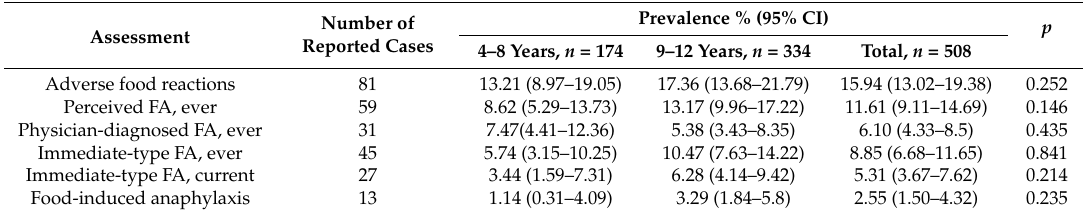
Table 3. Prevalence estimations.